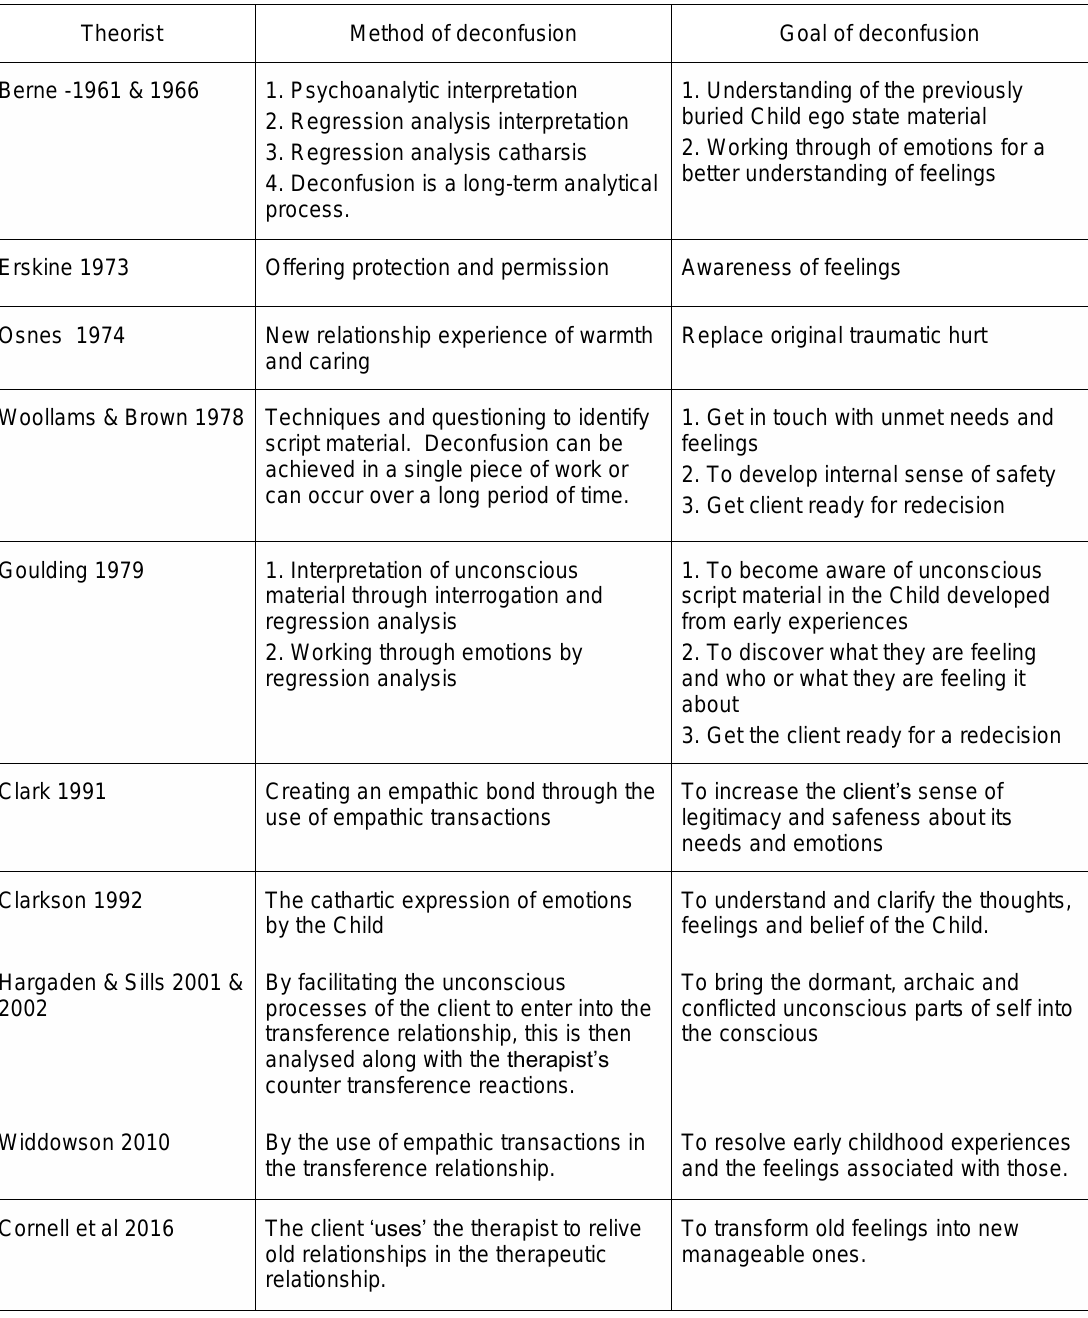
Table 1: Deconfusion of Child: Method and Goal